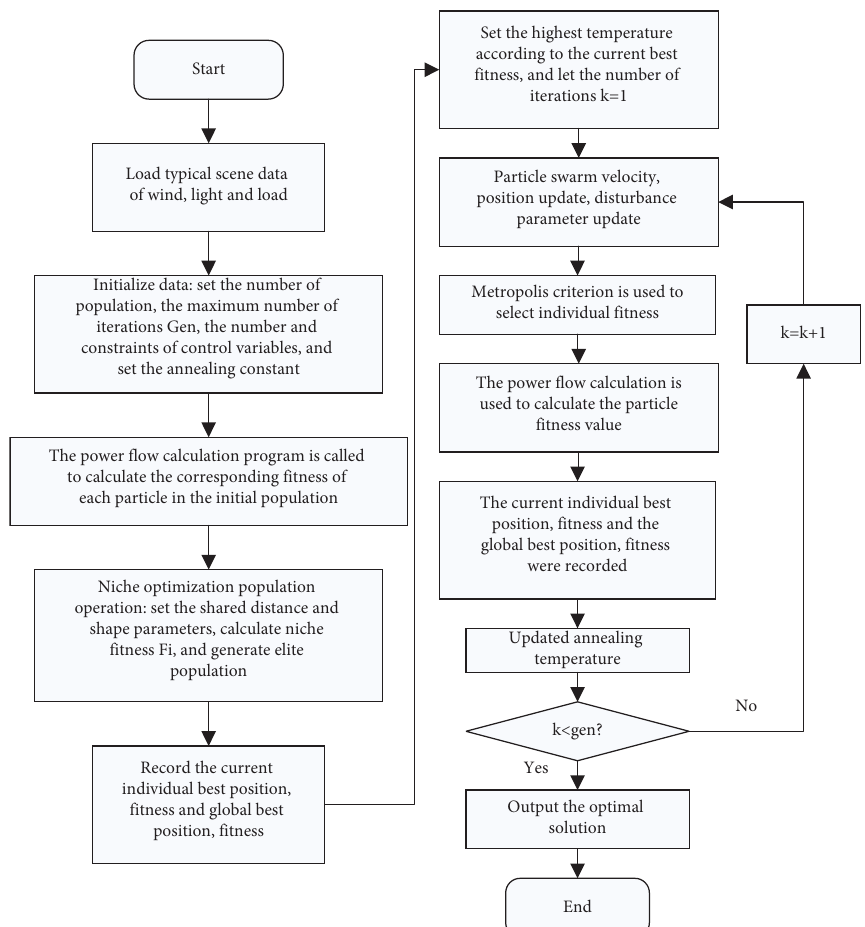
Figure 2: Computational process fow of improved simulated annealing particle swarm optimization algorithm.